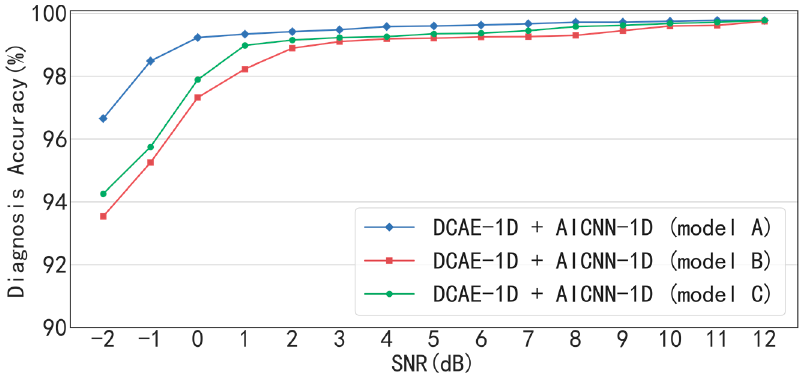
Figure 11. Diagnosis accuracy of AICNN-1D with input-corrupt training and global average pooling, with clean-input training and with fully-connected layers.